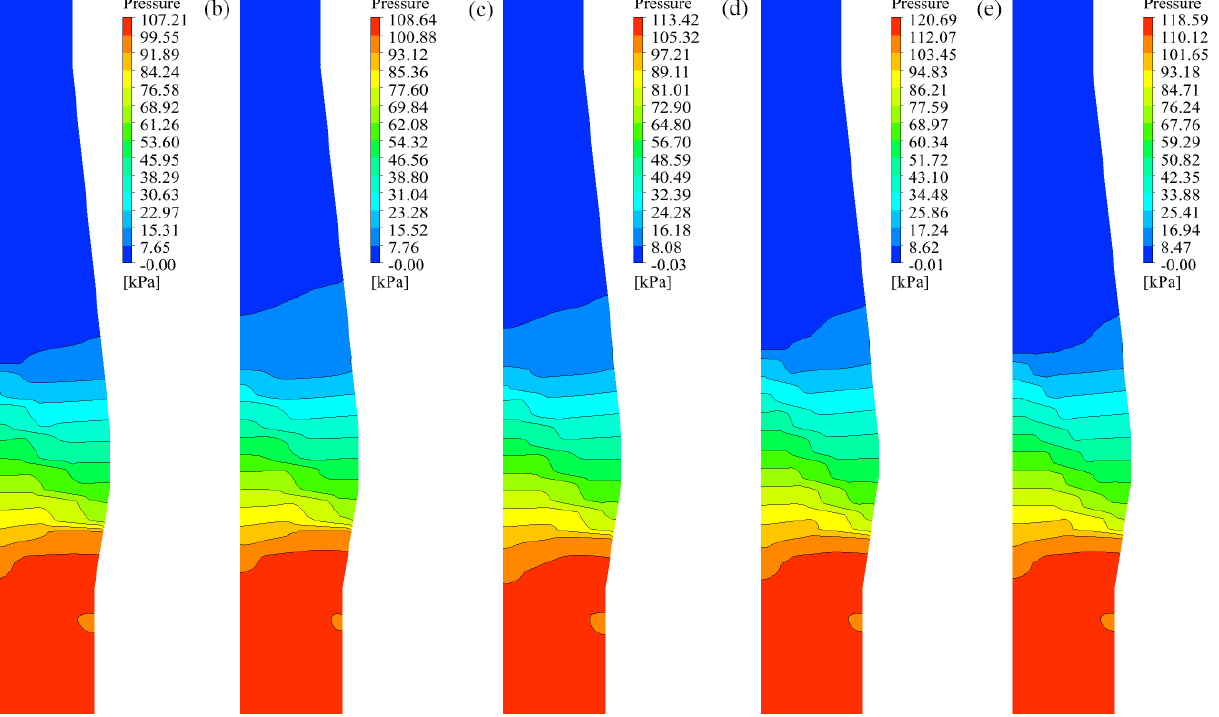
Table 7. Pressure drop of the whole furnace and the cohesive